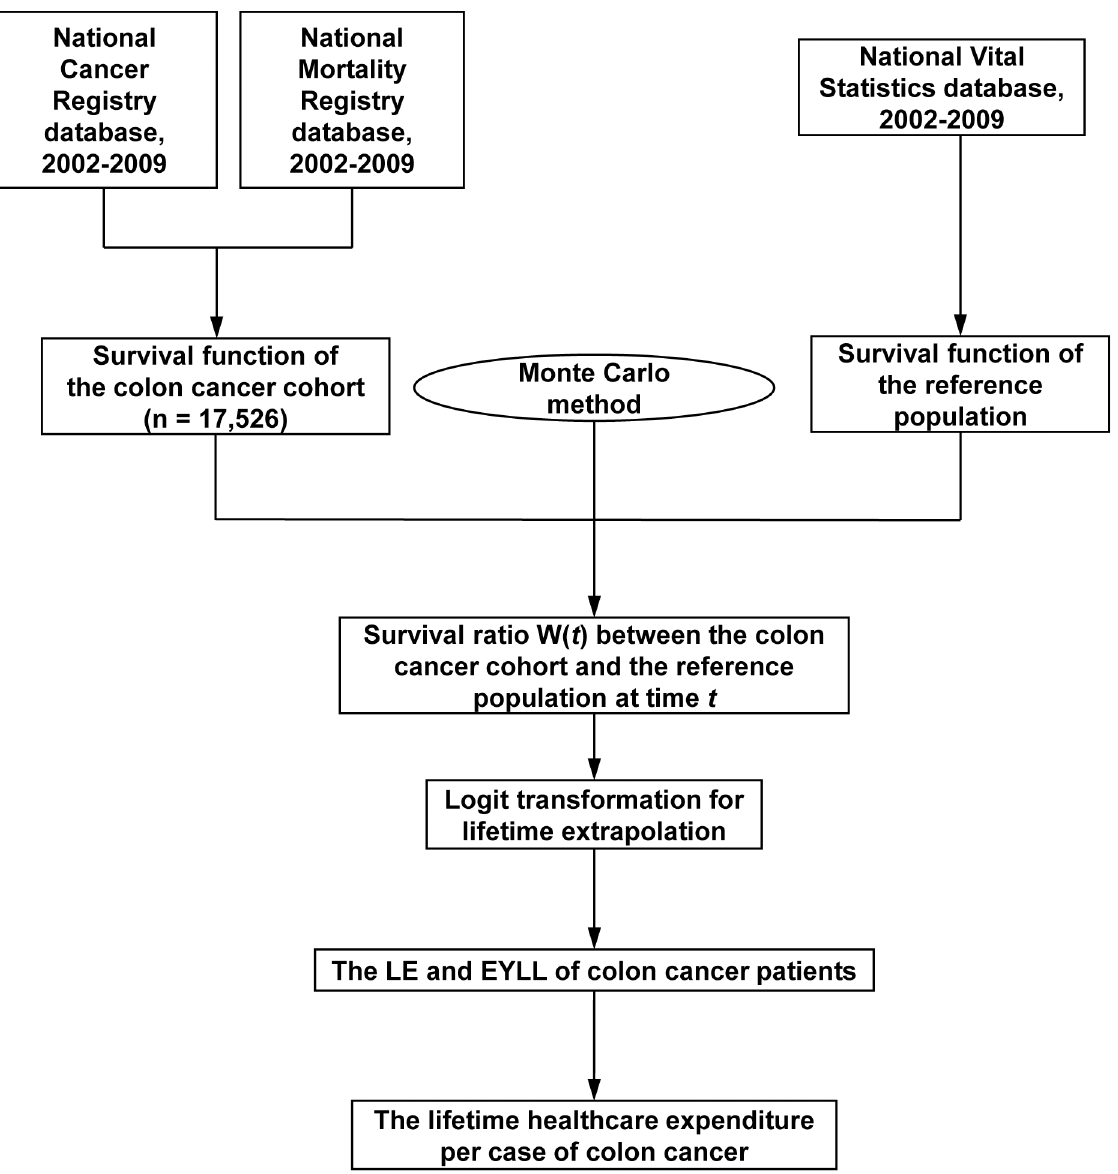
Fig 1. Flow chart of how the data were collected and semiparametric survival extrapolation method was conducted. (LE: life expectancy, EYLL: expected years of life